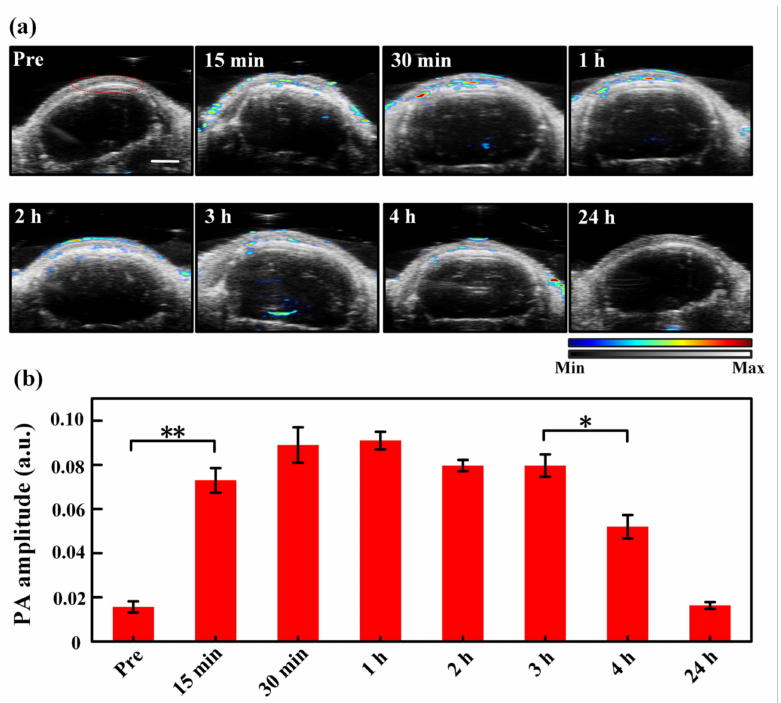
Figure 4. ( a ) Ultrasound (the grey background) and PA (the colored values) images of the tumor region with time pre- and post-MNs puncturing. The region encircled by the red curve in the “Pre” picture is the region of interest (ROI) used for data analysis, which is identical for all images acquired at different time moments. The color bar indicates the intensities of PA/US signals. ( b ) Quantitative PA amplitude of ICG signals (spectral unmixing) in the tumor region at different time points after MNs puncturing. **, p < 0.01, *, p < 0.05 (tested by Student’s two-tailed, unpaired t -test). The error bars in ( b ) are standard deviations. Scale bar: 2